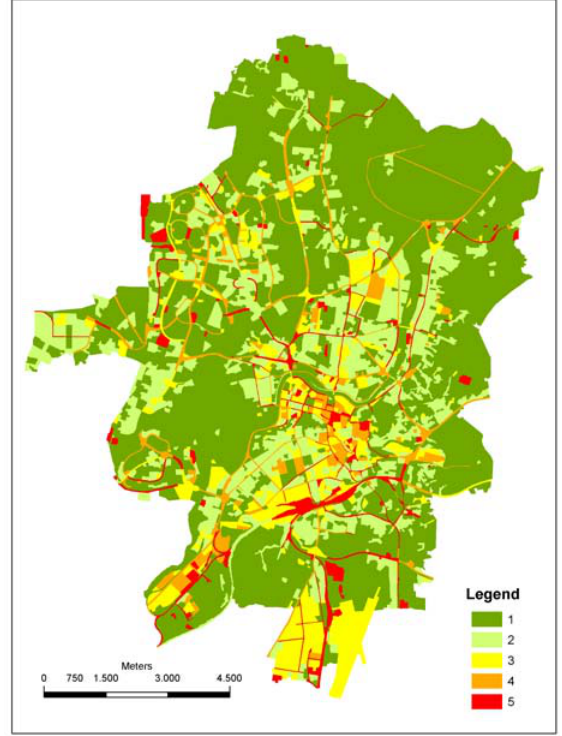
Fig. 1. Sensitivity of territorial units to chemical pollution in urbanized core of Vilnius city Legend of categories according to scores of sensitivity to chemical pollution (S): 1 – very low (S ≤ 12.5), 2 – low